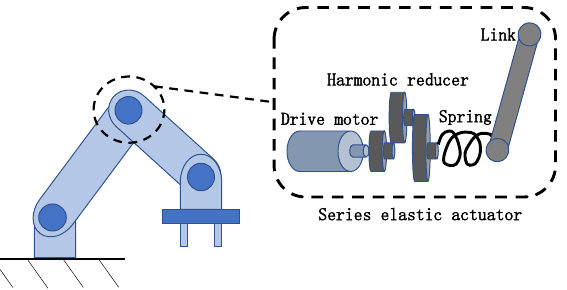
Figure 1. Schematic of an elastic-joint robot driven by an SEA.